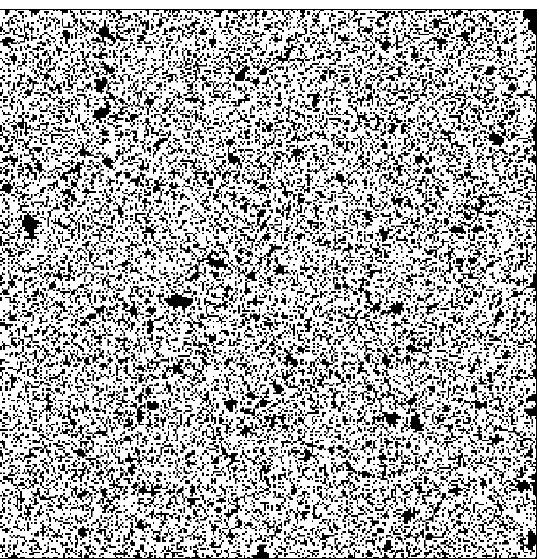
Figure A1. The surface morphology of the sealing interface under the microscope.